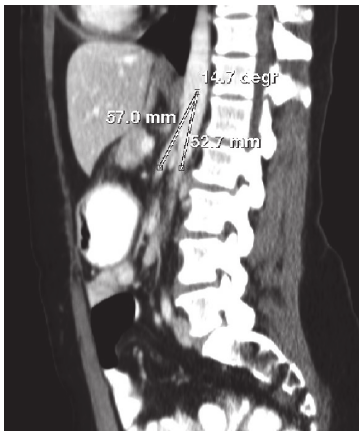
Figure 9: CT sagittal view showing an angle of 14.7 degrees between the SMA and aorta (Case Report Two).